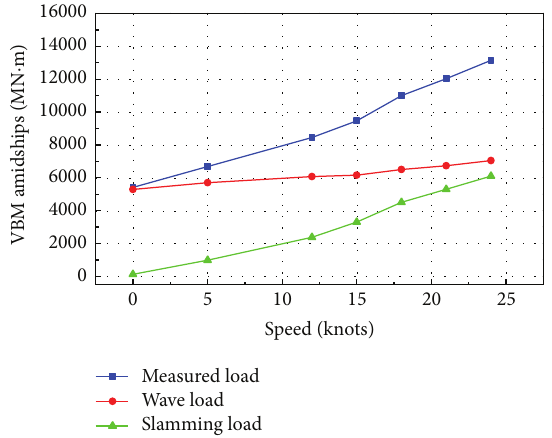
Figure 16: VBM components amidships at different sailing speeds (scheme